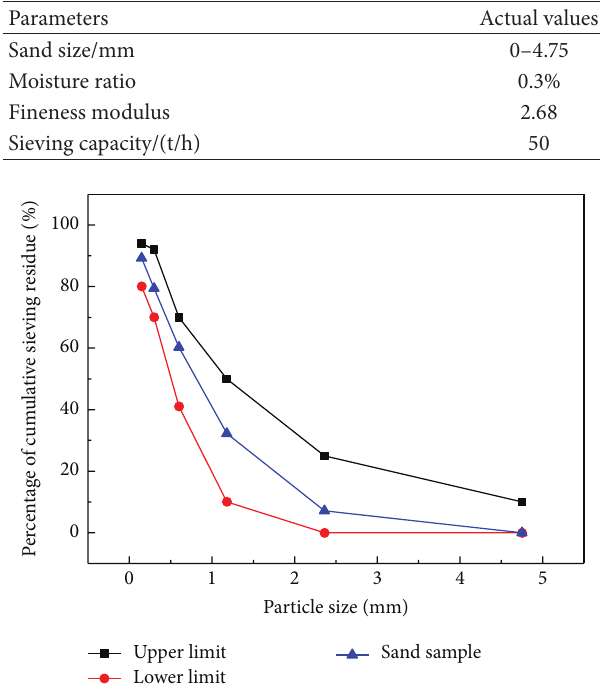
Figure 3: Grading curves of sands.